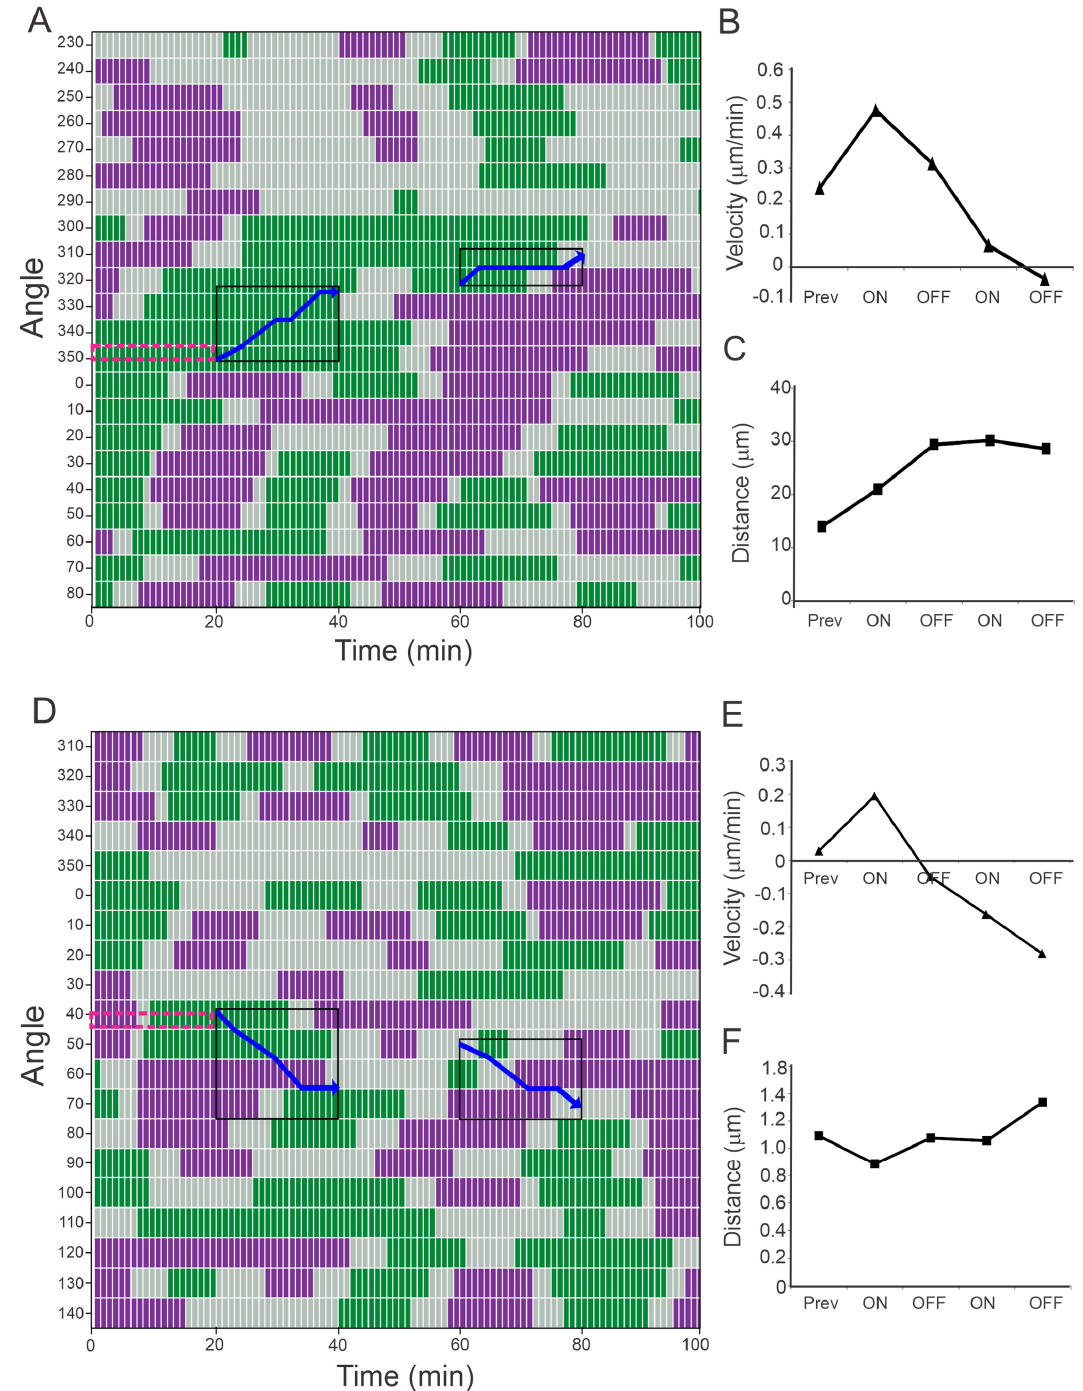
Figure 3. Quantification of PC12 growth cone velocity of projection. Multivariate time series plot of discretized velocities of projection at different angles. ( A – C , cell #1) and ( D – F , cell #2). Green, purple, and gray correspond to positive, negative, and null velocities, respectively. Black squares indicate the angles where the laser was located and blue arrows the displacement of the spot. In both cells, positive velocities were registered for at least 10 min previous to the first round of irradiation, at the angles of the spot location (red dotted squares). ( B , E ) show the median values of the velocities of projection, and ( C , F ) the median values of the cumulative distance, in both cases at the angles where the spots were located during the irradiated (ON), non-irradiated (OFF), or previous to irradiation (PREV)